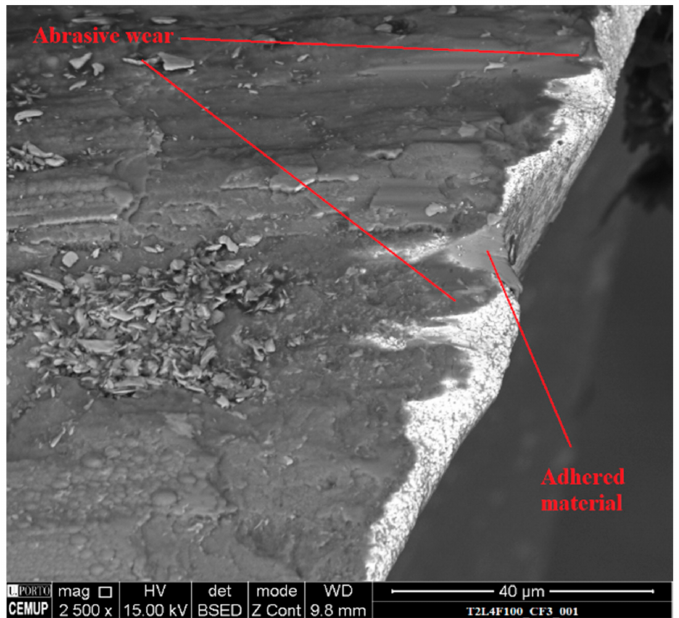
Figure 6. SEM image of the clearance face of T2L4F100 tool at 2500 ×